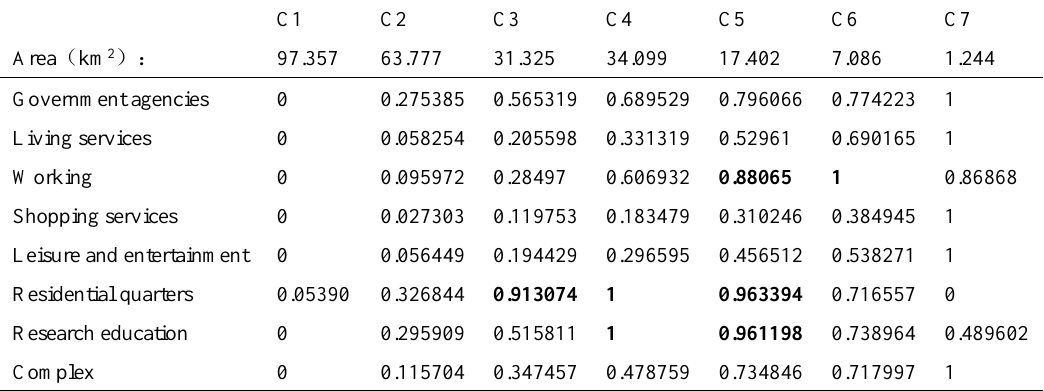
Table 3. POI standardized values of various plots (16: 00 ~ 19: 00 O)